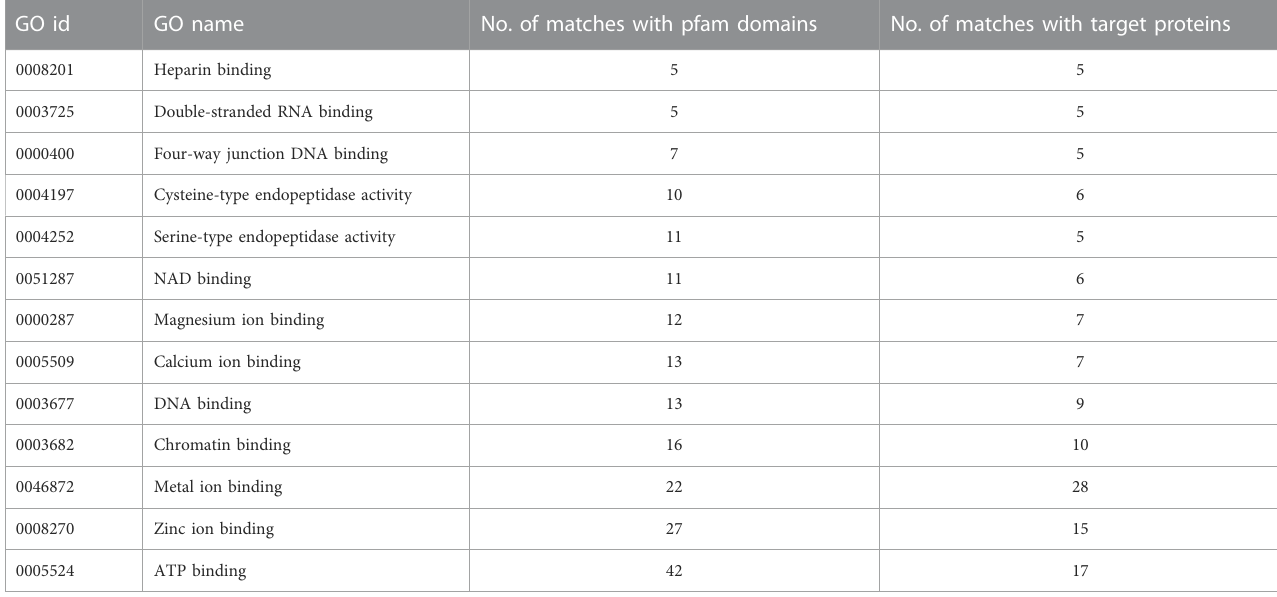
TABLE 2 GO terms associated with suramin targets, their number of associations with the Pfam domains identi fi ed in the targets, and the resulting number of associations with the targets themselves. Only terms that matched at least fi ve different targets are included. GO id